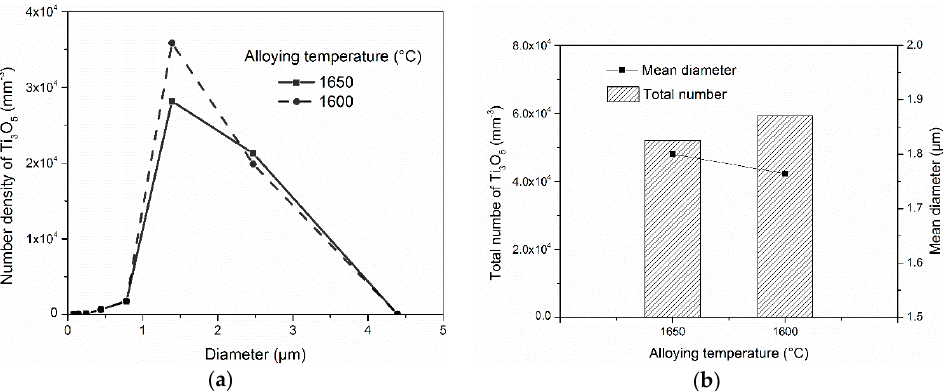
Figure 7. The influence of alloying temperature on Ti 3 O 5 ( a ) size distribution and ( b ) mean diameter and total number at solidus temperature.